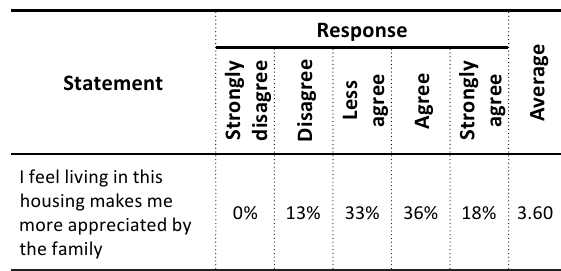
Table 12. Social construct descriptive statistics